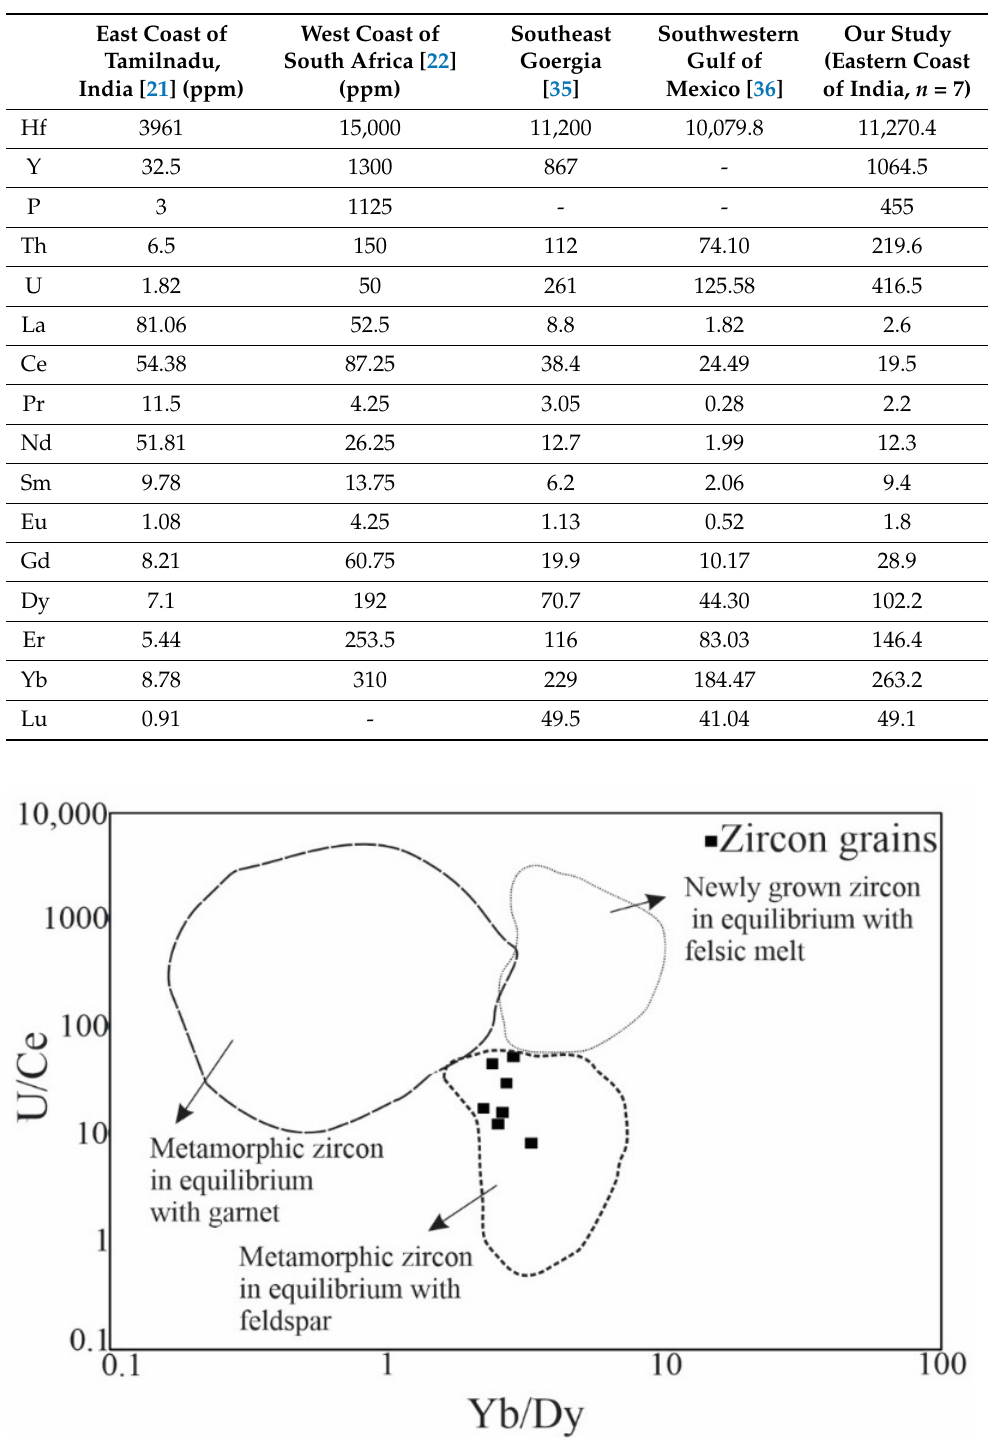
in this in this study.